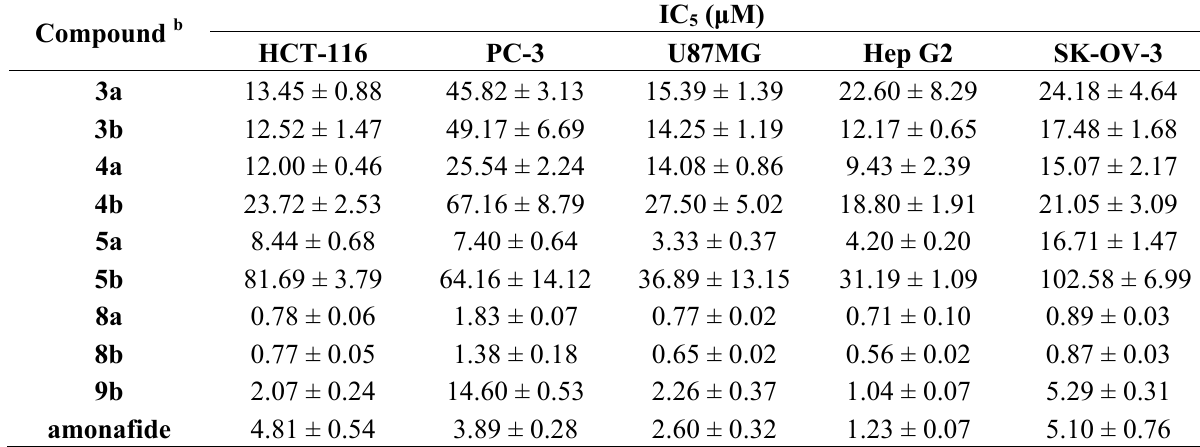
Table 2. IC values of synthetic intermediates over five cancer cell lines a . 50 Compound b